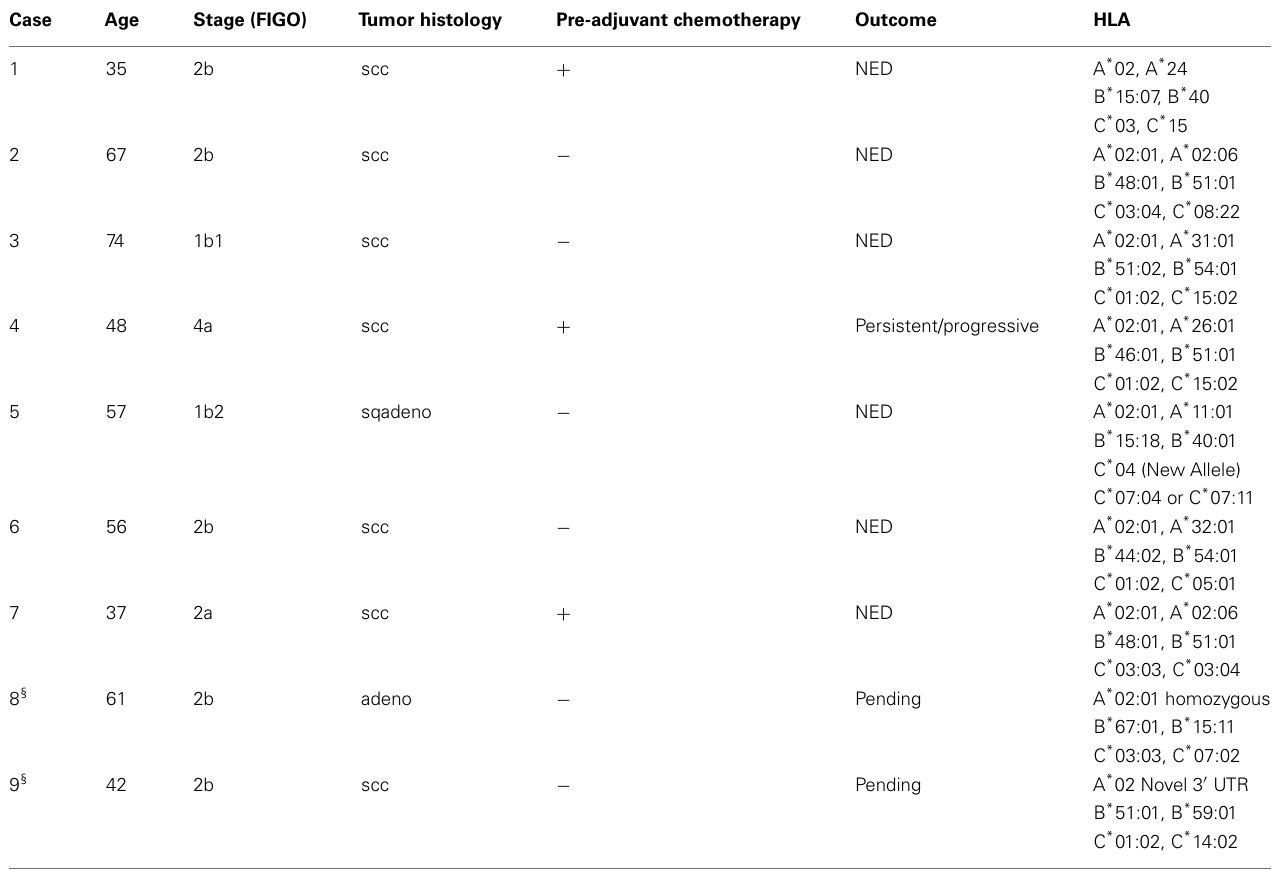
Table 1 | Human papilloma viruses-16 + cervical tumor samples from HLA-A ∗ 02 + patients. Case Stage (FIGO)